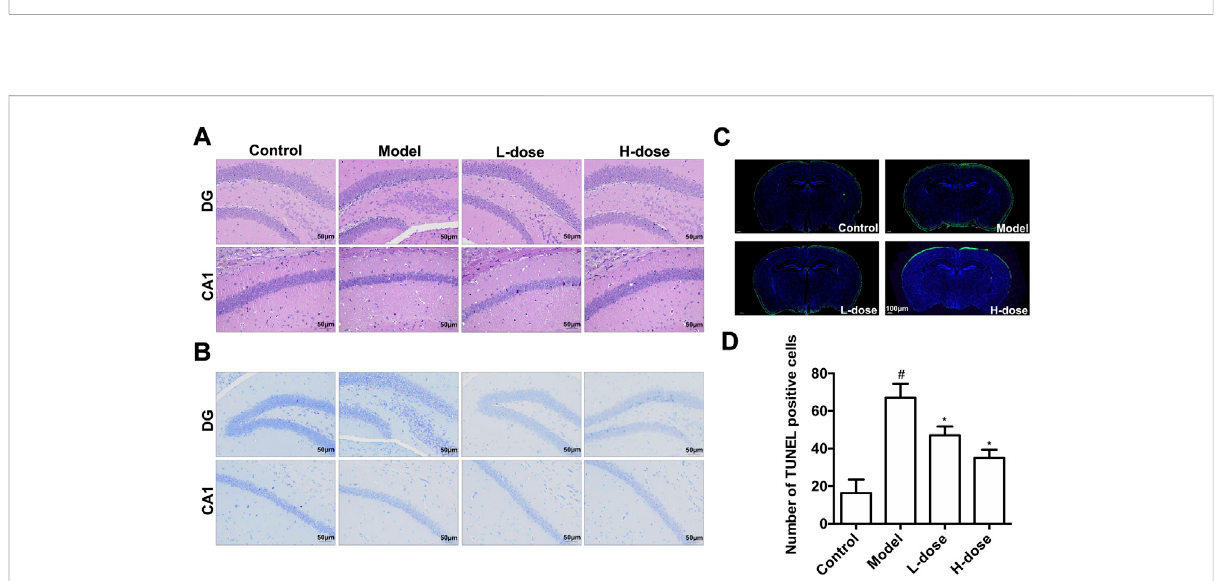
FIGURE 5 BLWE reversed neuron pathological damage and neuronal apoptosis in APP/PS1 mice. H&E staining of hippocampus DG and CA1 areas (A) , Scale bar = 50 μ m. Nissl staining of hippocampus DG and CA1 areas (B) , Scale bar = 50 μ m. TUNEL staining of hippocampus DG and CA1 areas (C)